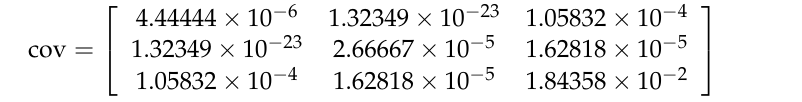
Figure 6. Substrate consumption curve during fermentation with L. salivarius in the filmogenic solution with fitting of the proposed model.